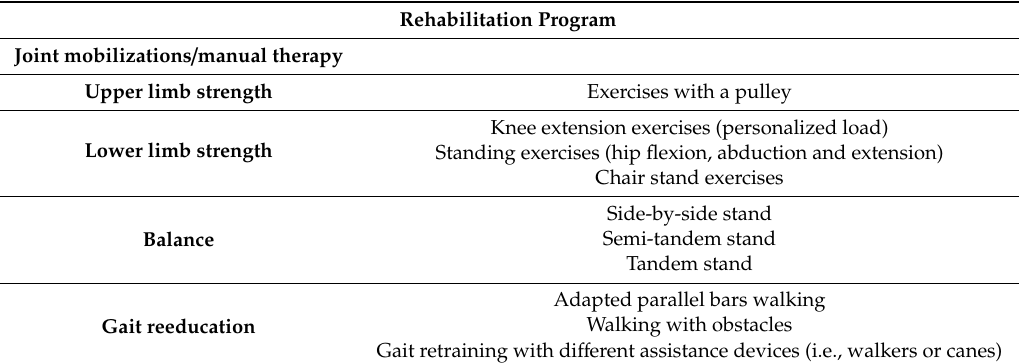
Table 1. Rehabilitation